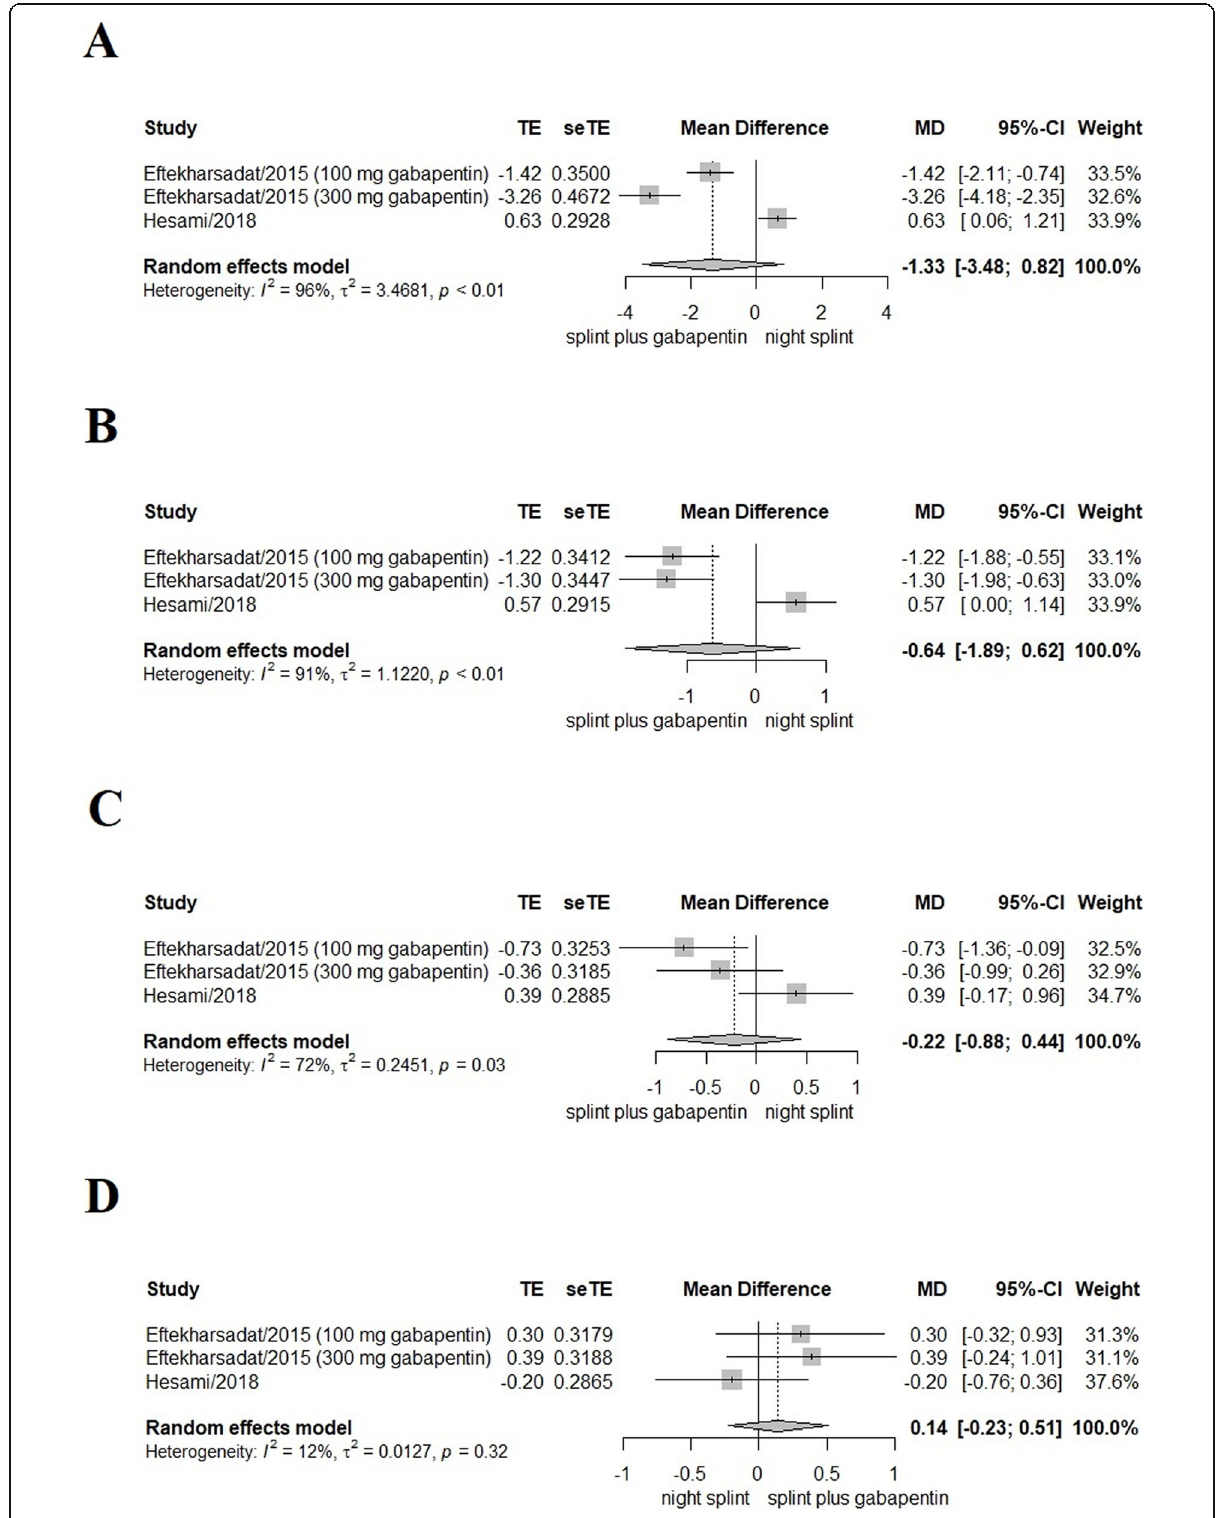
Fig. 4 Forest plot meta-analysis comparing changes between gabapentin and control group in the sub-group analysis; (TE = treatment effect, seTE = standard error of treatment effect): a Symptom Severity Scale (SSS), b Functional Severity Scale (FSS), c visual analogue score (VAS), and d grip